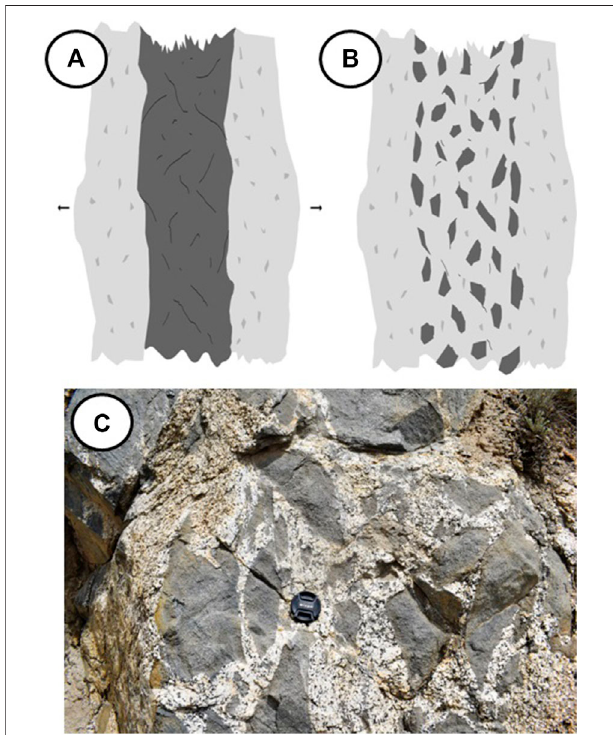
FIGURE 7 | Hypothetical model illustrating the likely mechanism of (A) injection of ma fi c magma into highly crystallized ( > 65%) felsic granite magma that (B) ruptured and brecciated into angular ma fi c enclaveswarms under the extensional environment of granite magma, which is very well demonstrated (C) at outcrop scale, similar to as shown in Kumar et al. (2016).